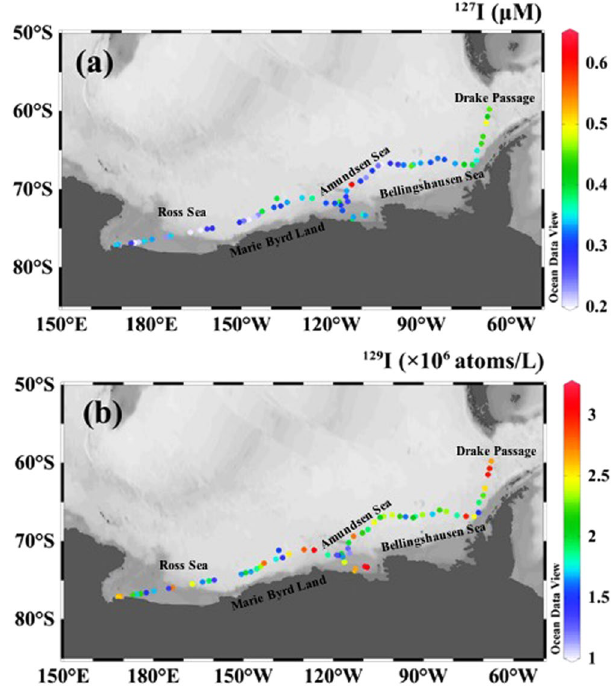
Figure 1. Variation in concentration of total 127 I and 129 I in the Antarctic surface seawater. The original map was constructed by a free software Ocean Date View (ODV 4.7.8) (Schlitzer, R., Ocean Data View, odv.awi.de,